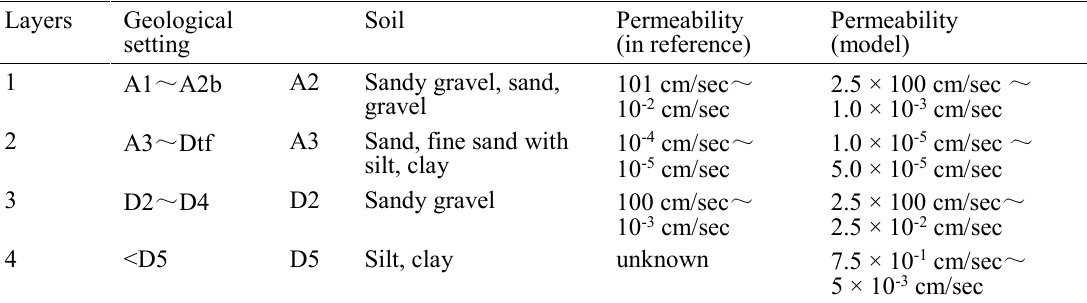
Fig. 6 Water exchange between land and ocean. Table 1 Hydrogeological information used in the